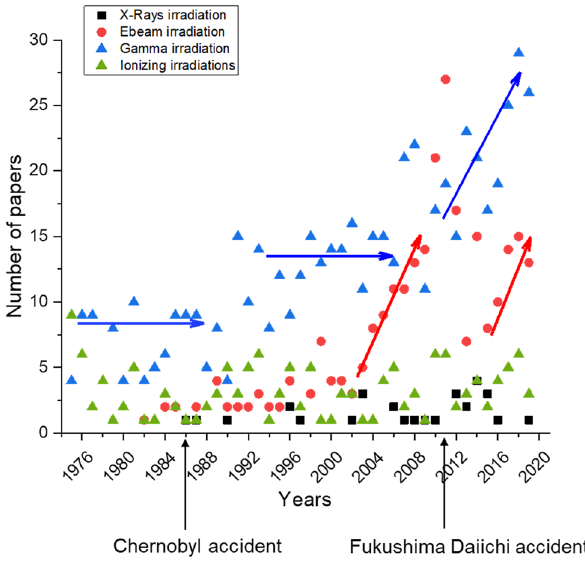
Figure 4: Number of papers overtime ( 1975 – 2019 ) referring to X - ray irradiation ( black ) , e - beam irradiation ( red ) , and gamma irradiation ( blue ) . The fi tting curves ( dashed line ) are given to ease the